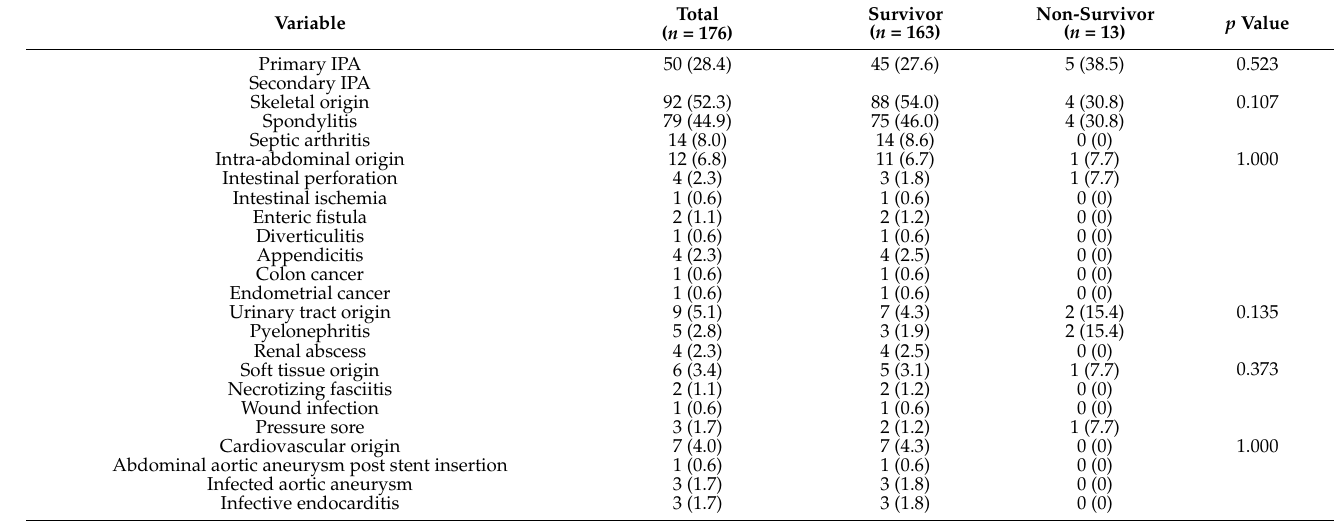
Table 2. Types and origins of iliopsoas abscess by survival